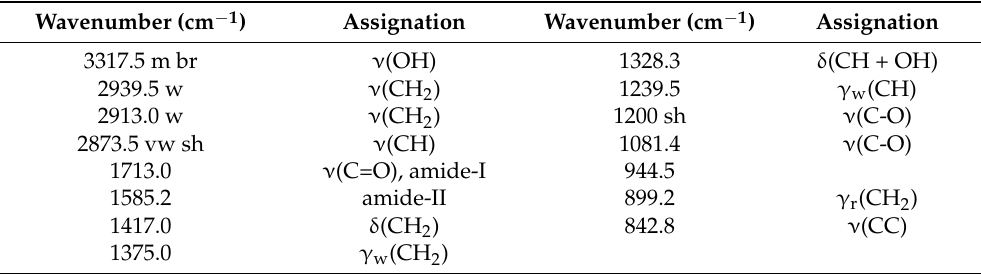
Figure 6. Recorded and best-fit ATR-FTIR spectra of the BTCP-AE-FM nanofiber composite assuming that the spectrum is the linear combination of the spectra of the FM and BTCP-AE. The blue arrow indicates the absorbance drop of the ester group ν (C-O) stretching frequencies. Table 1. Characteristic IR absorptions and plausible assignations of peaks of the BTCP-AE-FM nanofiber